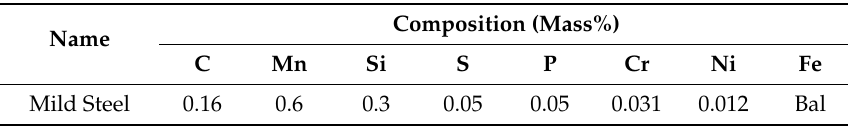
Table 1. Chemical composition of mild